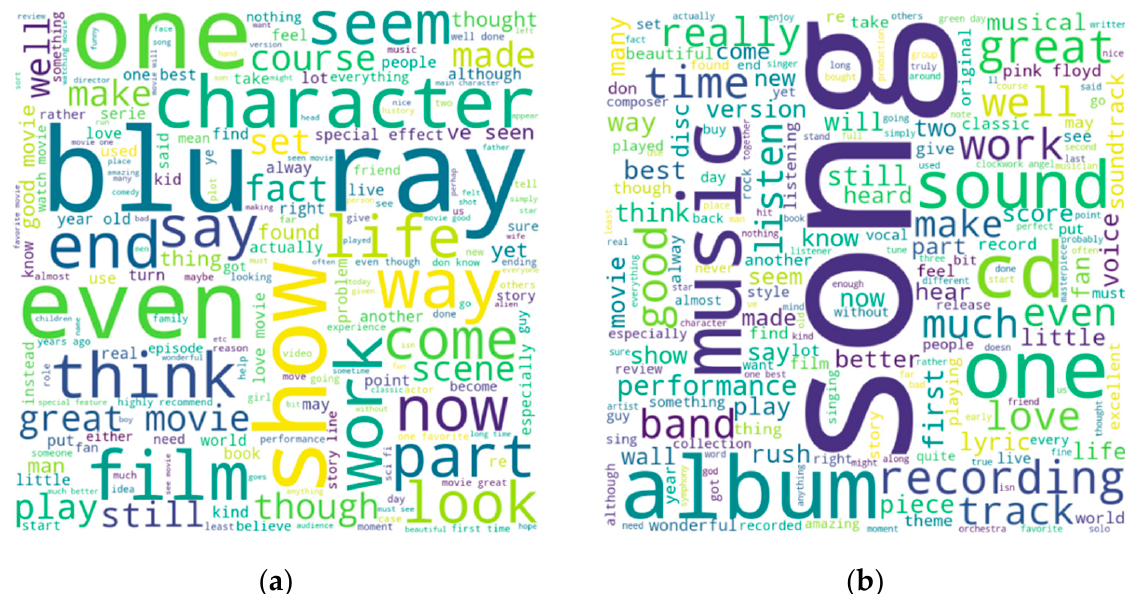
Figure 1. Word cloud of the combined dataset: ( a ) Amazon Movie dataset in the first panel; ( b ) MARD (Multimodal Album Reviews Dataset) dataset in the second panel.